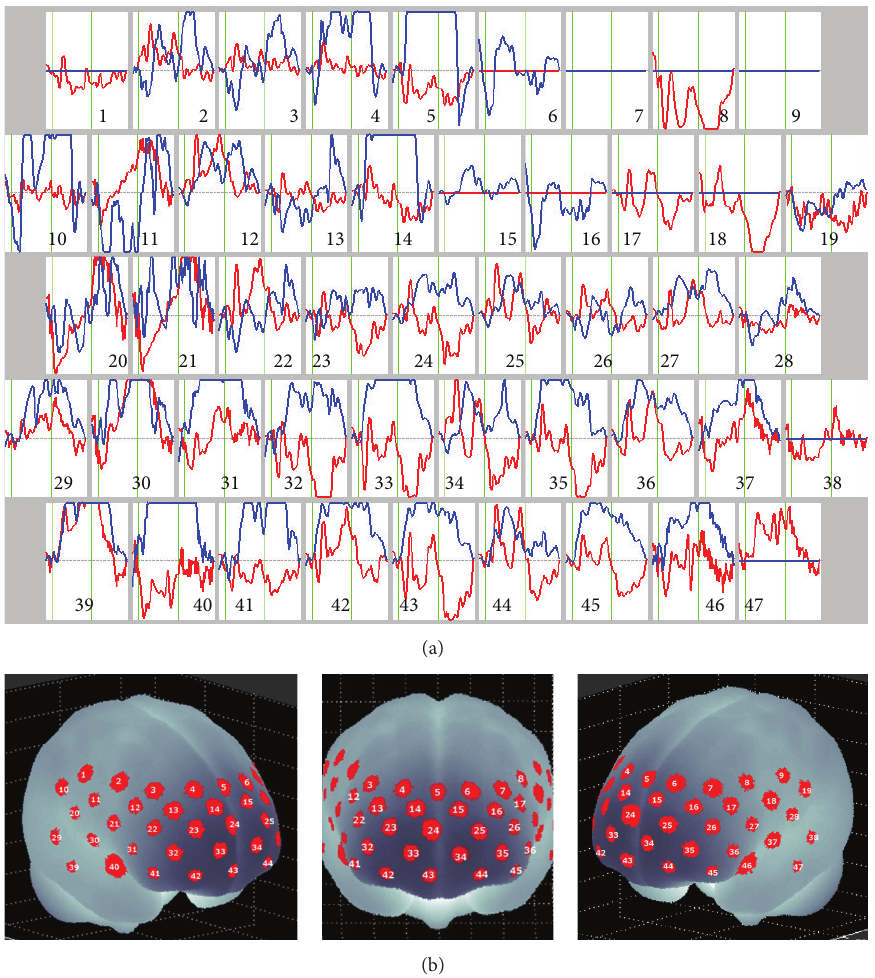
Figure1:(a)Grandaveragedwaveformsof[oxy-Hb]duringverbalfluencytask(betweentwogreenverticallinesineachgraph)in47channels over the frontal and temporal regions measured by NIRS. Red and blue lines represent pretreatment and posttreatment, respectively. (b) The 47 measuring areas are labeled CH1 to CH47 from the right posterior to the left